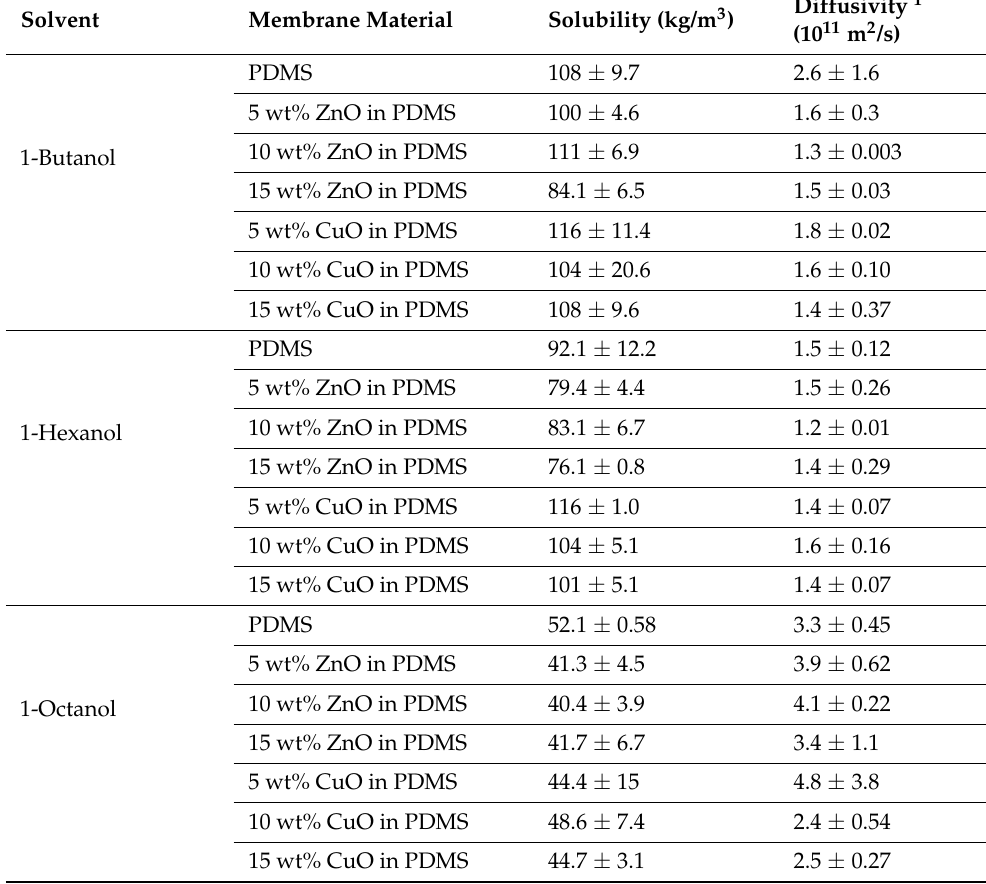
Table 3. Summary of solvent absorption in PDMS